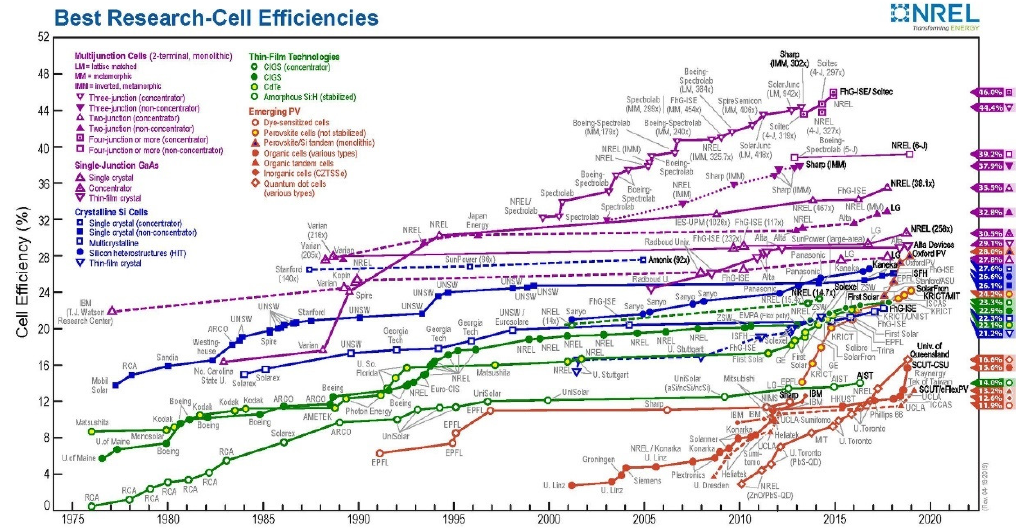
Figure 1. PV efficiency research developments of various types from 1975 to 2020 [26].